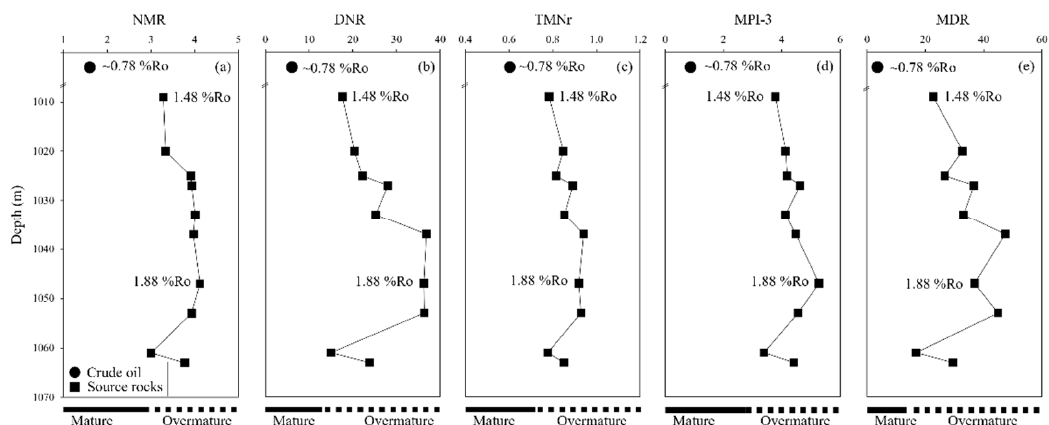
Figure 4. Distribution of thermal maturity parameters derived from aromatic hydrocarbons of the source rock extracts and crude oil. The oil sample is at a depth of 800–820 m. ( a ) methylnaphthalene ratio (MNR = 2-MN/1-MN); ( b ) dimethylnaphthalene ratio [DNR = (2,6-DMN + 2,7-DMN)/1,5-DMN]; ( c ) trimethylnaphthalene ratio [TMNr = 1,3,7-TMN/(1,3,7 + 1,2,5) -TMN]; ( d ) methylphenanthrene index [MPI-3 = (2-MP + 3-MP)/(1-MP + 9-MP)]; ( e ) methyldibenzothiophene index (MDR = 4- MDBT/1-MDBT).